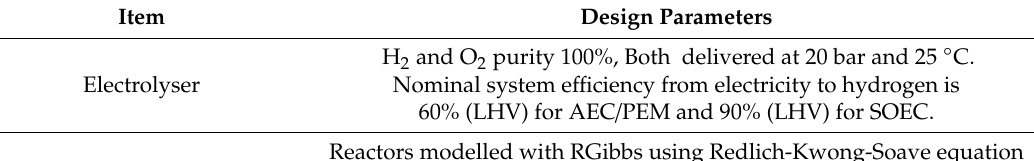
Table 2. Summary of process design parameters for Aspen